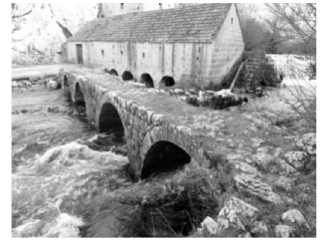
Figure 6. Castel Vitturi, Kaštel Lukši ć (B3).